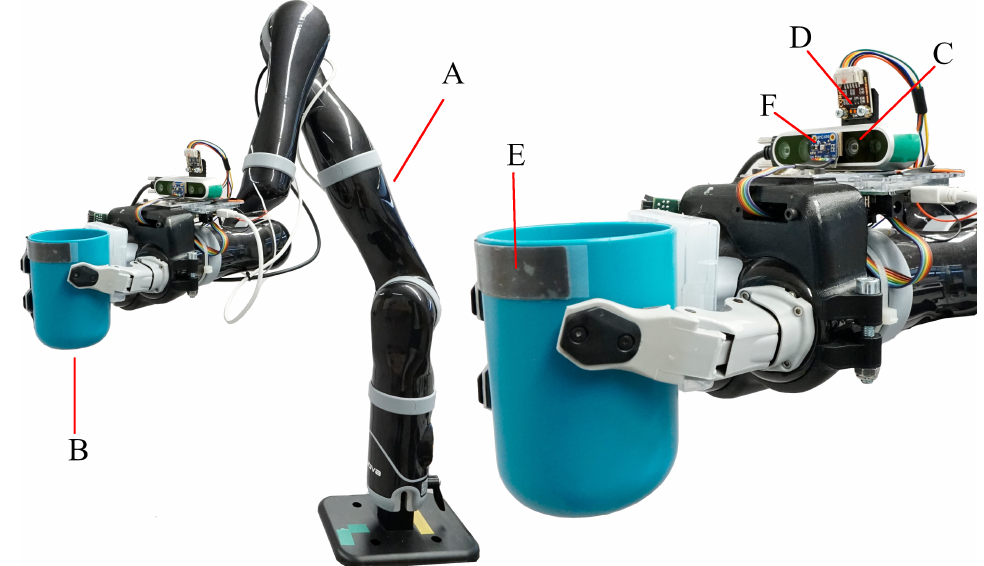
Figure 1. The robotic system. (A) Kinova Jaco Robot Arm (B) Drinking Cup (C) Intel RealSense D435 Camera (D) VL53L1X Distance Sensor (E) Tacterion Plyon Force and Capacitive Sensor. (F) Environ- mental Sensor (part of our previous work [15]) which is not used in this